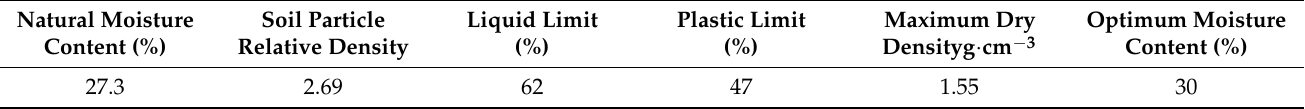
Table 1. Basic physical properties of red